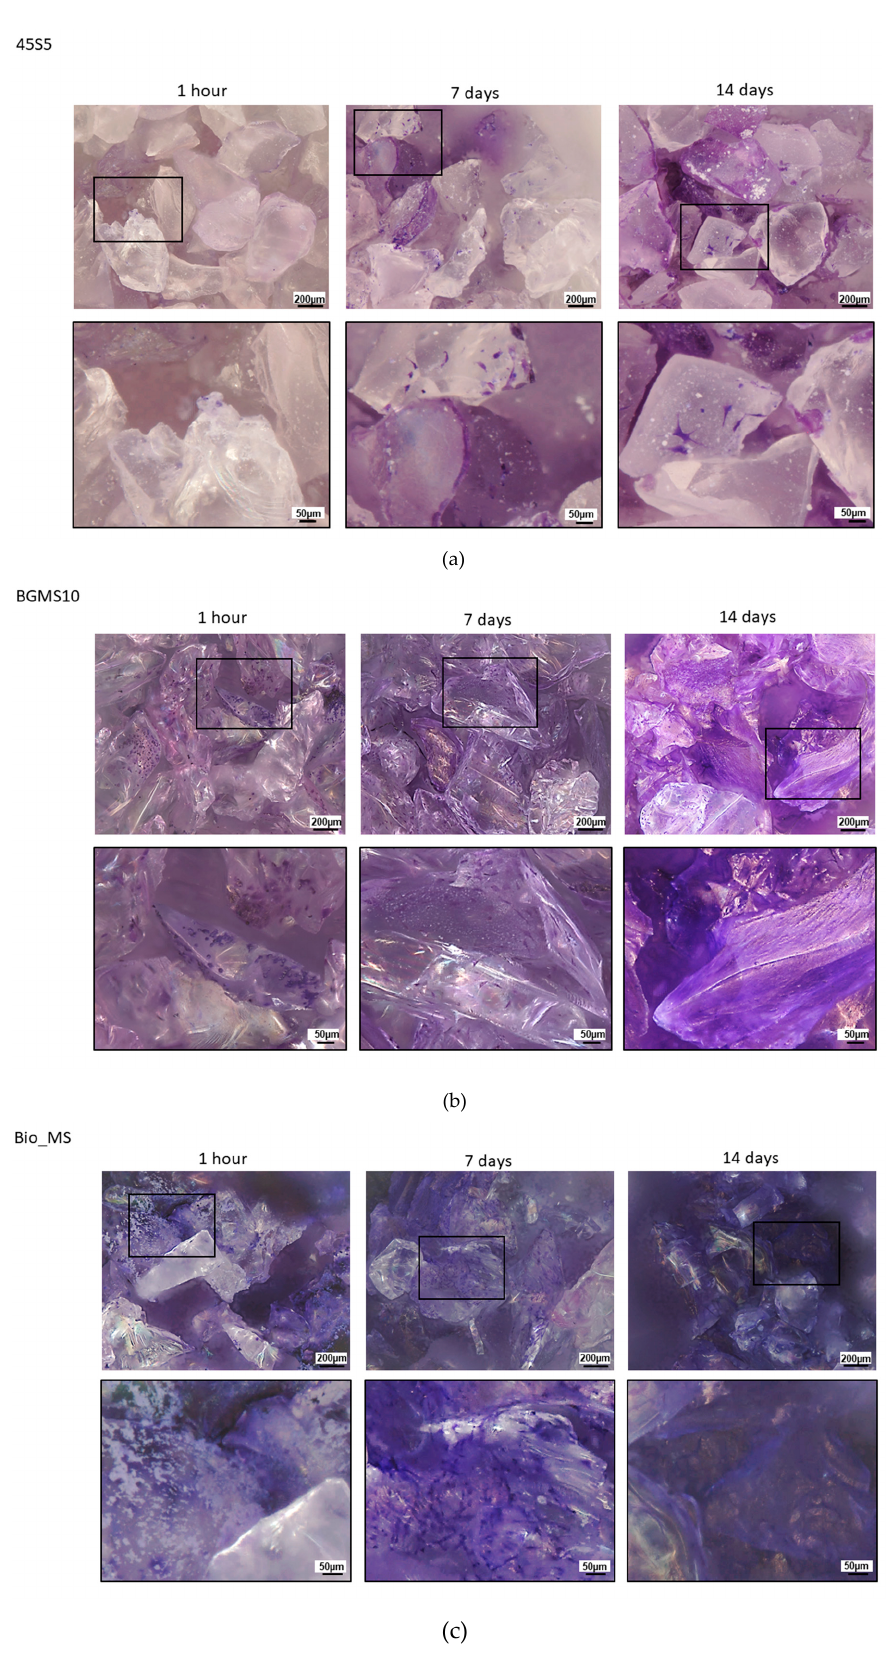
Figure 2. Comparison between 45S5 ( a ), BGMS10 ( b ) and Bio_MS ( c ): crystal violet staining of BM–MSCs seeded on 45S5 ( a ), BGMS10 ( b ) and Bio_MS ( c ) at 1 h, 7 days and 14 days after seeding (cells density: 3000/mg).